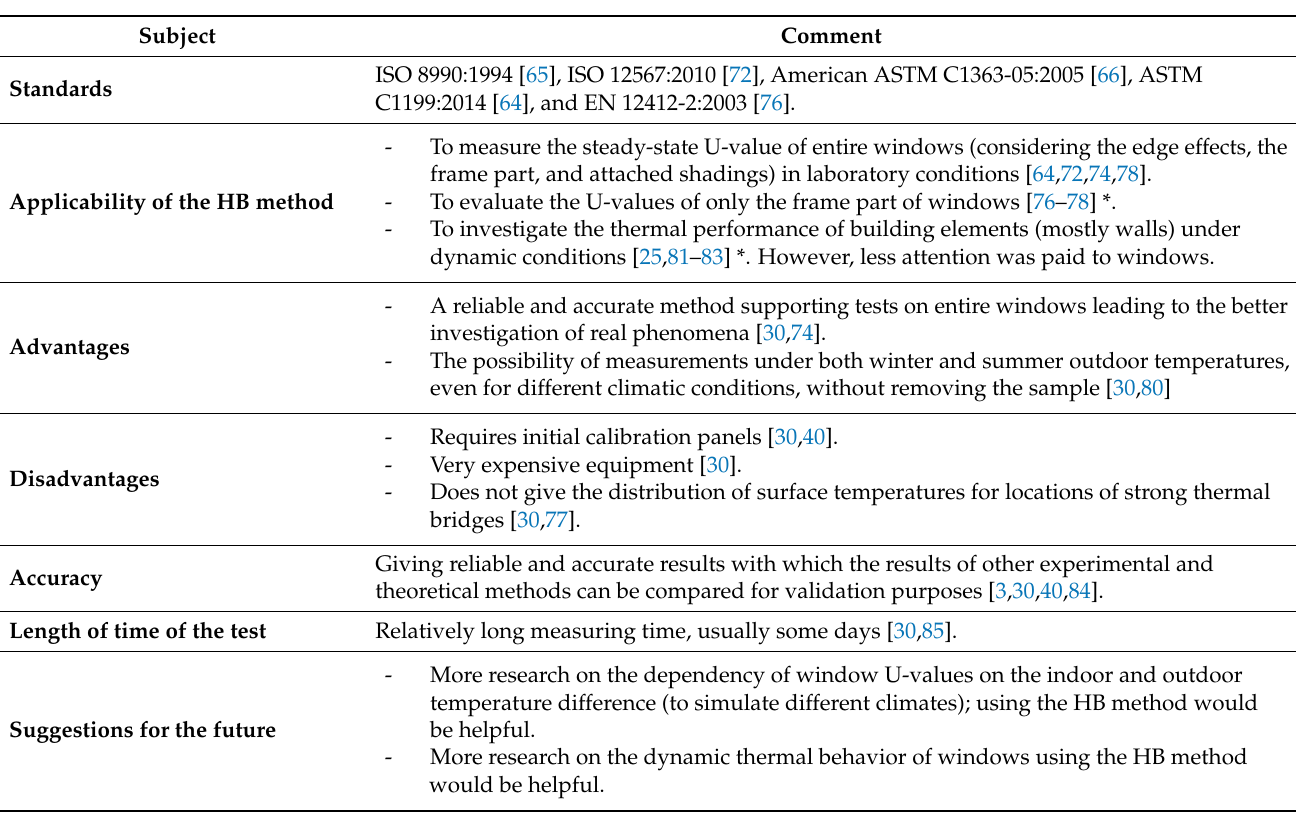
Table 3. Summary of the HB method with a focus on glazing